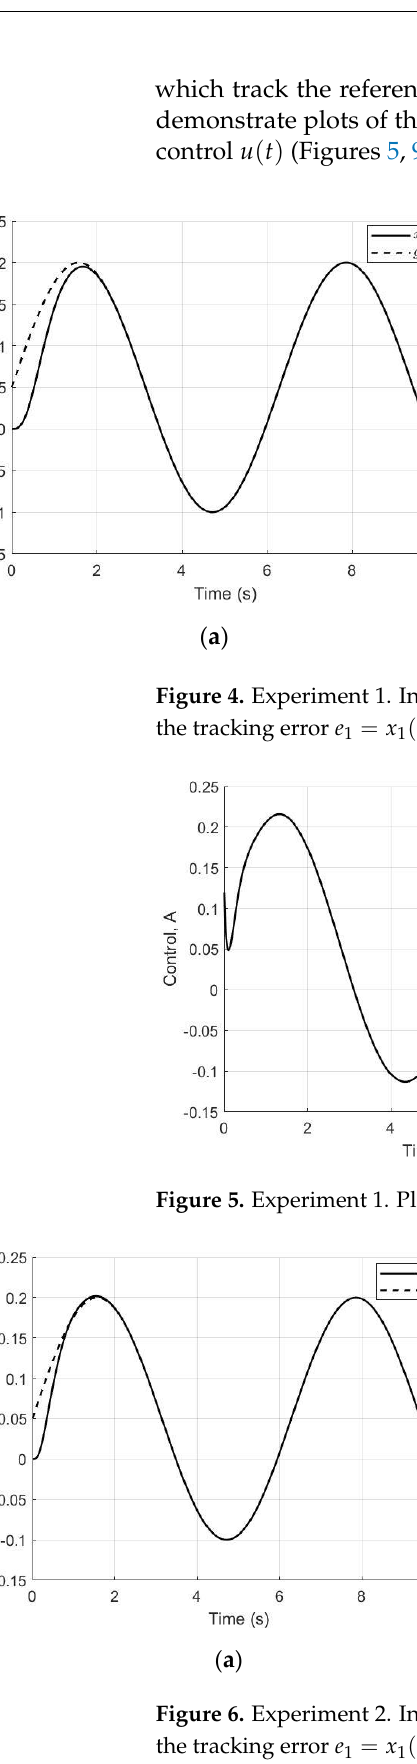
Figure 6. Experiment 2. In ( a ), plots of the reference signal g ( t ) and the output x 1 ( t ) ; in ( b ), plot of the tracking error e 1 = x 1 ( t ) − g ( t ) .